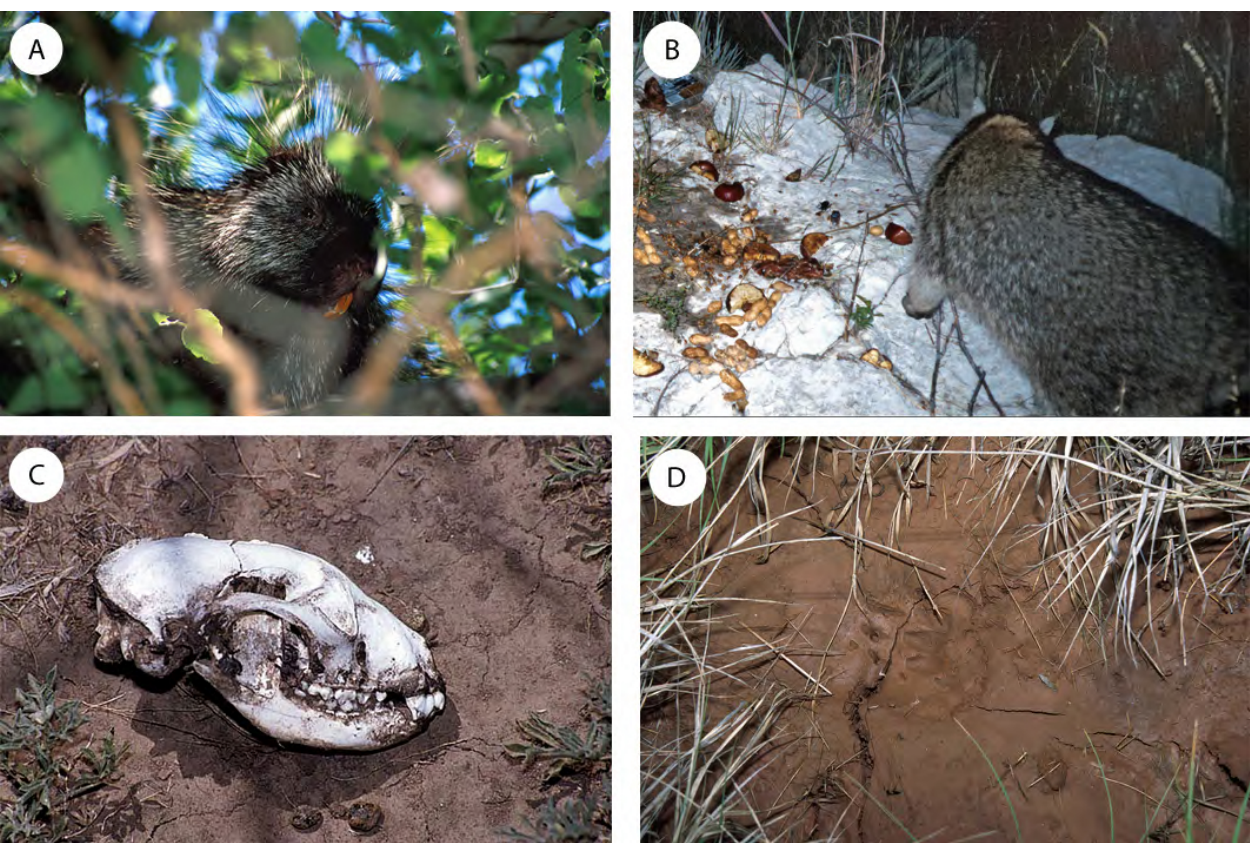
Figure 5. Mammals found in Lake Meredith National Recreation Area, Texas: A : Erethizon dorsatum , B : Procyon lotor at a bait station, C : Procyon lotor , skull, D : Taxidea taxus , tracks. Photographs by Michael